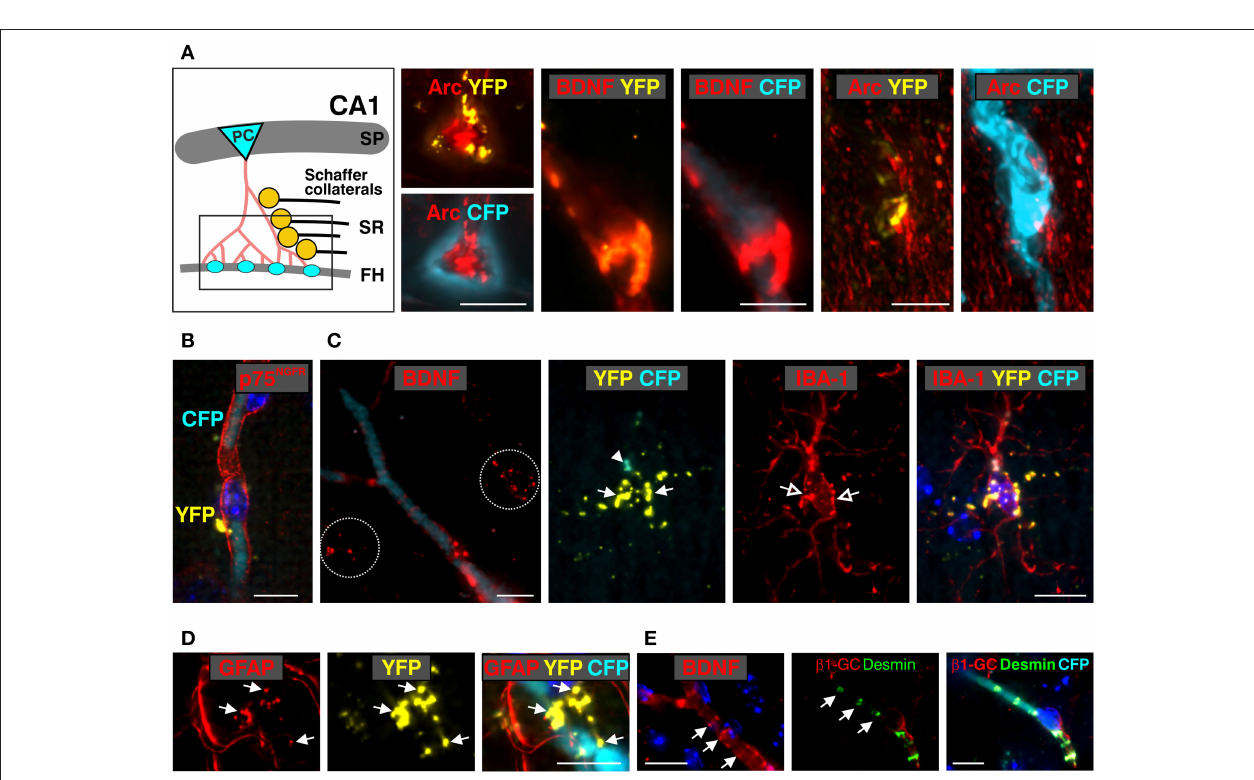
FIGURE 6 | Co-localization of anti-BDNF with Bdnf exon-IV-CFP and Bdnf exon-VI-YFP in the stratum radiatum (SR) and the vasculature of the fissura hippocampalis (FH) (see Supplementary Video 2 ). (A) Schematic overview of the stratum radiatum (SR) region of the hippocampal formation. Arc-positive (red) pyramidal cell (PC) dendrites contact the vascularized fissura hippocampalis (FH) embedded within a Bdnf exon-IV-CFP-positive capillary bed (left). BDNF immunoreactivity (red) co-localizes with Bdnf exon-VI-YFP puncta within this region covering a Bdnf exon-IV-CFP-positive blood vessel (middle). In another view of the FH region, the Bdnf exon-VI-YFP puncta contacting Arc-positive dendrites deeply entering the basal membrane of a Bdnf exon-IV-CFP-positive blood vessel is shown (right). Scale bars: 10 µ m. SP, stratum pyramidale. (B) Bdnf exon-VI-YFP contacting p75 NGF receptor-positive (red) endothelia cells of a Bdnf exon-IV-CFP-positive blood vessel. Nuclei are stained in dark blue with DAPI. Scale bars: 10 µ m. (C) The characteristic BDNF immunoreactivity pattern (red, dotted circles) seen in the SR region close to blood vessels outlined with Bdnf exon-IV-CFP. Bdnf exon-VI-YFP-positive labeling (closed arrows) is observed close to an IBA-1-positive (red) microglia soma (open arrows) that itself targets Bdnf exon-IV-CFP at the microglia pole (closed arrowhead). Scale bars: 10 µ m. (D) Bdnf exon-VI-YFP-positive pattern (closed arrow) observed in overlap with glial fibrillary acidic protein (GFAP)-labeled astrocyte endfeets close to a Bdnf exon-IV-CFP-positive blood vessel. Scale bars: 10 µ m. (E) BDNF-IR (red, arrows) in endothelial cells in a pattern resembling localization of desmin (green, arrows), a marker of pericytes. Pericyte processes embrace the abluminal endothelium wall of an exon-IV-CFP-positive blood vessel encircled by β 1-guanylyl cyclase (GC)-positive (red) smooth muscle cells. Scale bars: 10 µ